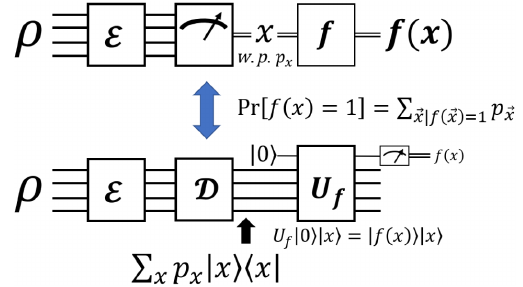
FIG. 13. The diagram of circuit conversion from the origi- nal decision problem to the fully quantum picture. Here, ρ is an n -qubit initial state, E is a noisy process, D is a perfect dephasing noise map, f is a classical binary function on an n - bit string x , and U f is a quantum circuit that simulates f as U | 0 (cid:5) | x (cid:5) = | f ( x ) (cid:5) | x (cid:5) . See the main text for